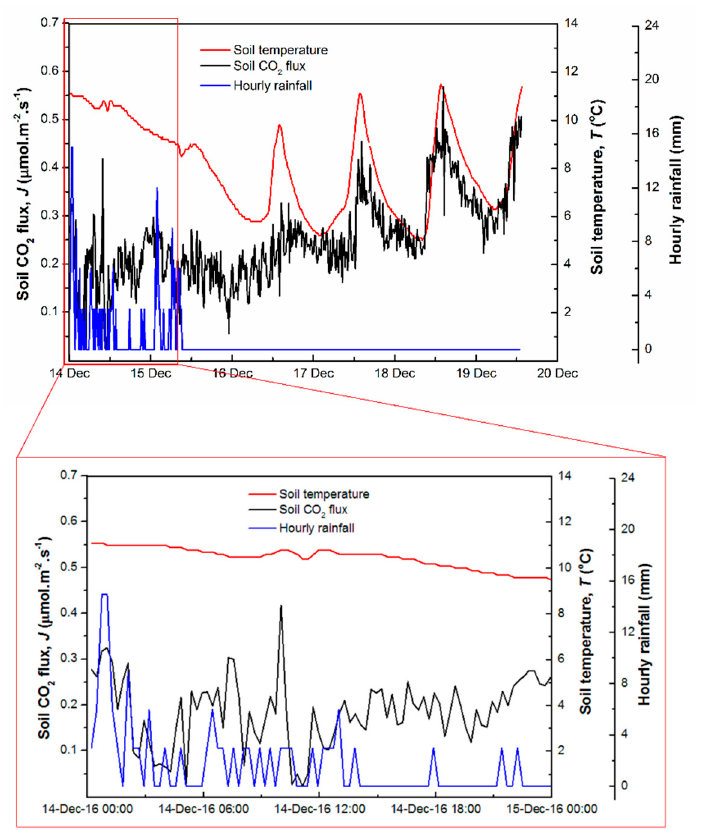
Figure 10. Correlation between CO 2 flux from soils and soil temperature together with rainfall data recorded at Location A (Dec 14, 2016 to Dec 20, 2016).